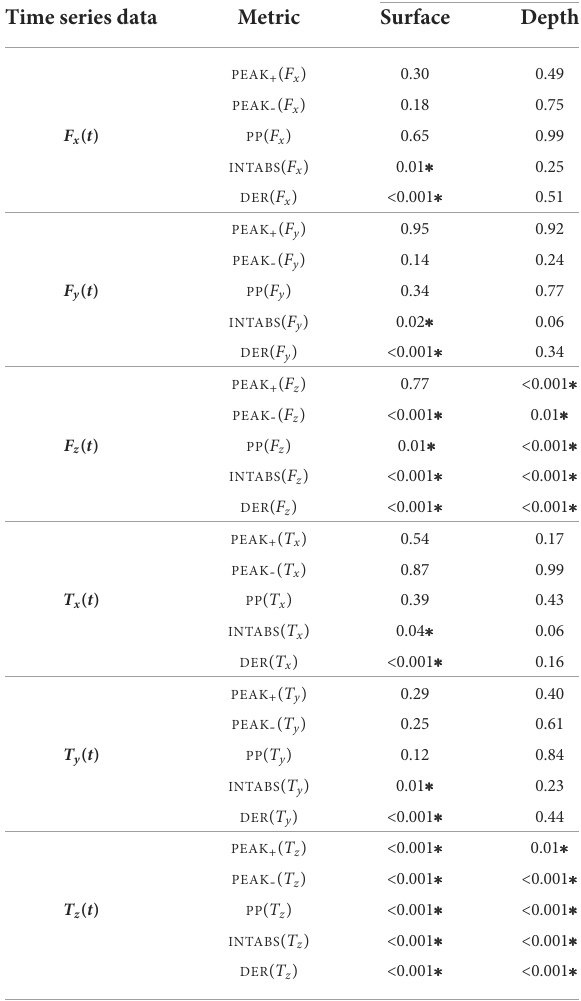
TABLE 1 Statistical results for force/torque-based